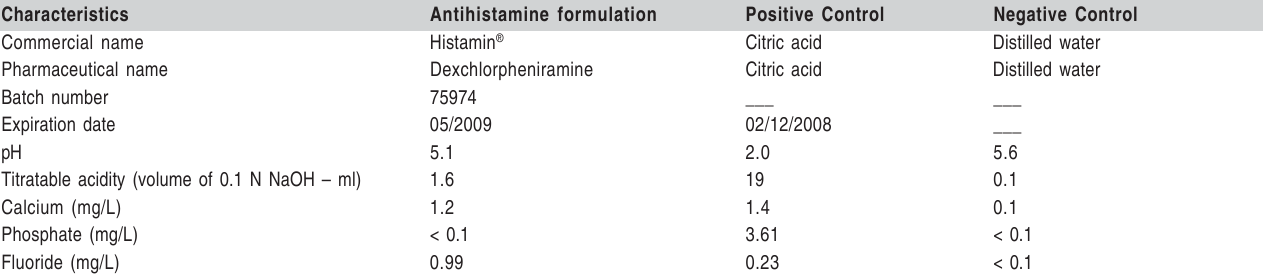
Fig. 4 – Representative SEM micrographs of bovine enamel at baseline (A) and after immersion in distilled water (negative control) for 5 min (B), 15 min (C) and 30 min (D). Note absence of eroded areas at higher magnification (x2000) (E). Table 1 – Chemical parameters of the antihistamine formulation and controls tested in the present